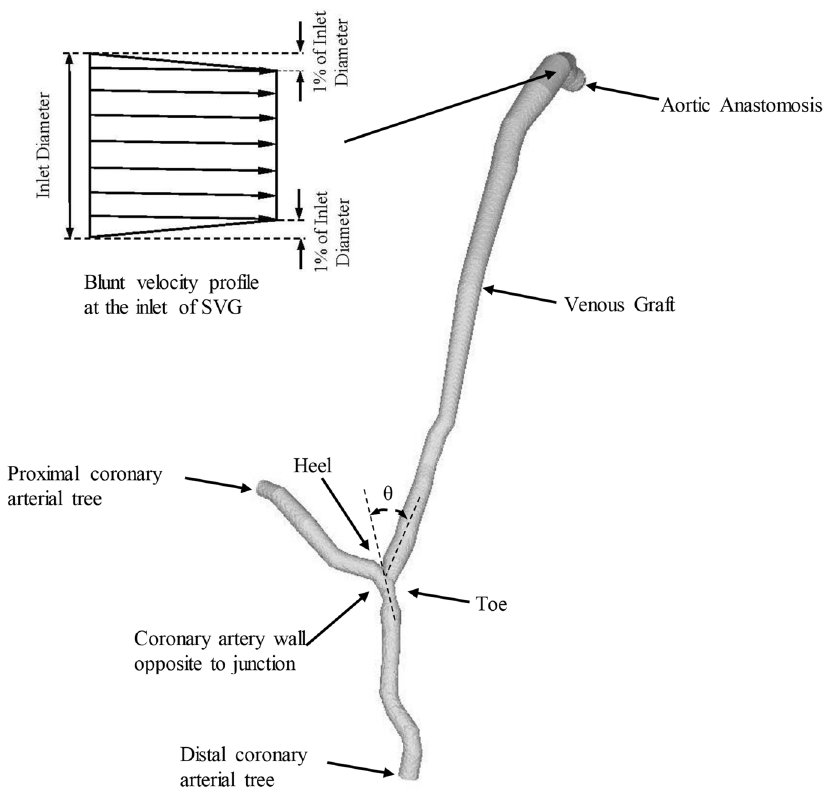
Figure 2. End-to-side SVG obtained from patient CTA, where h is the graft angle between SVG and coronary artery. A blunt velocity profile was used in the FE simulation.